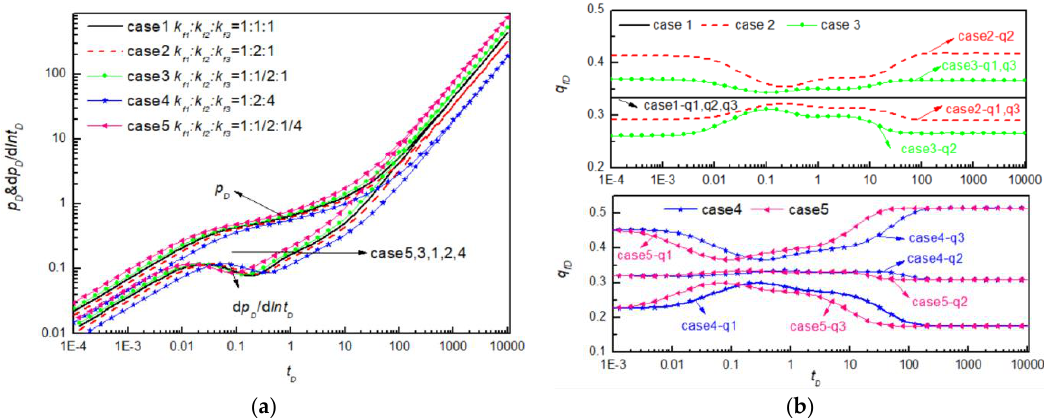
Figure 5. Pressure response and flux distribution of heterogenous permeability. ( a ) Pressure and pressure derivative; ( b ) flux distribution of each hydraulic fracture.